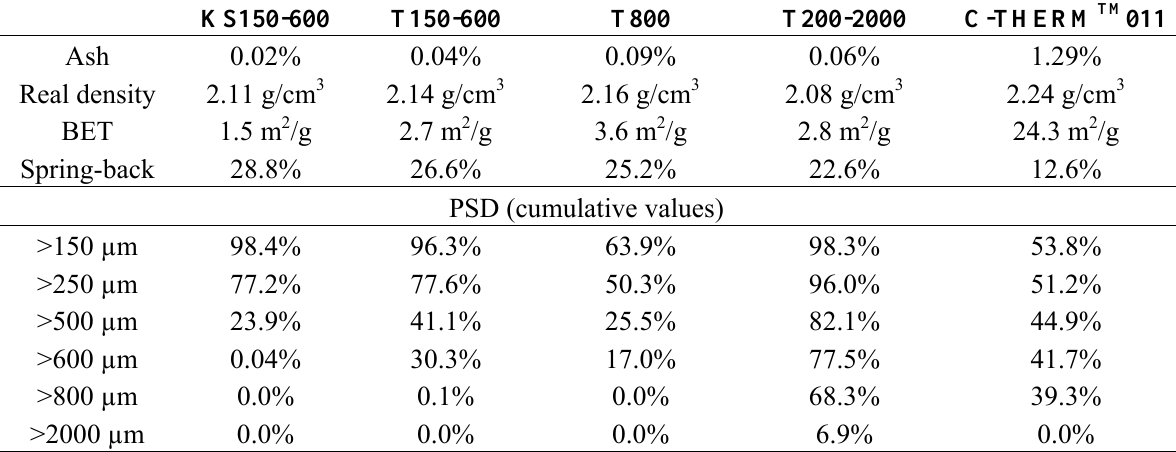
Table 3. TIMREX ® graphite properties (lots tested in brake pad